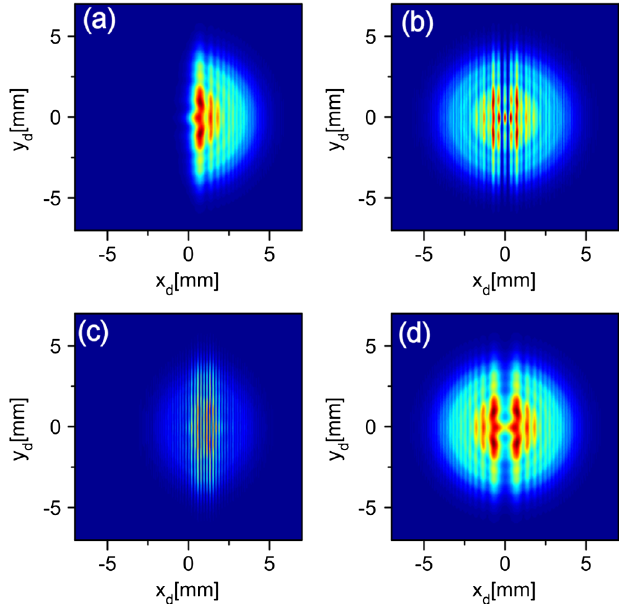
FIG. 8. Simulations of the beam profile at the detector. (a) The beam transmitted through one arm of the autocorrelator. (b) Zero overlap of two temporally and spatially coherent beams [ (cid:8) 12 ð (cid:2) Þ ¼ 1 ]. (c) A 2 mm overlap of two temporally and spa- tially coherent beams [ (cid:8) 12 ð (cid:2) Þ ¼ 1 ]. (d) Zero overlap of two temporally incoherent beams [ (cid:8) 12 ð (cid:2) Þ ¼ 0